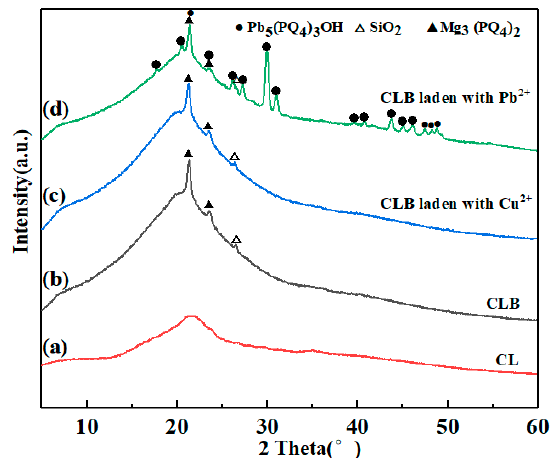
Figure 3. X-ray diffraction(XRD) patterns of CL ( a ), CLB ( b ) and CLB impregnated with 0.3 mM Cu(II) ( c ) and 0.3 mM Pb(II) ( d ) in single system.